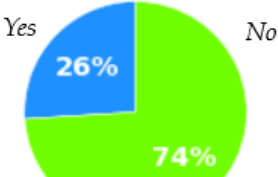
Figure 13. Answers for question of are the current IFRS standards satisfied holdings of cryptocur- rencies?